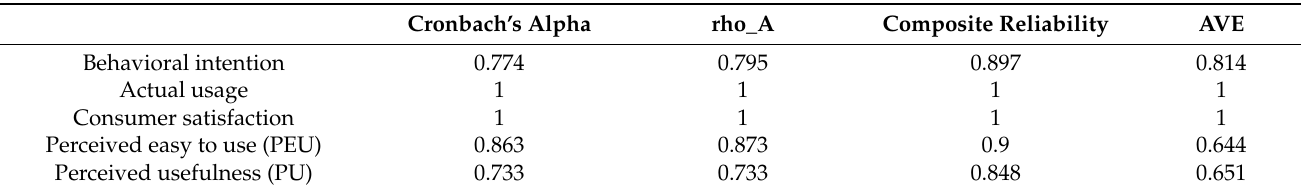
Table 3. Model reliability and validity.